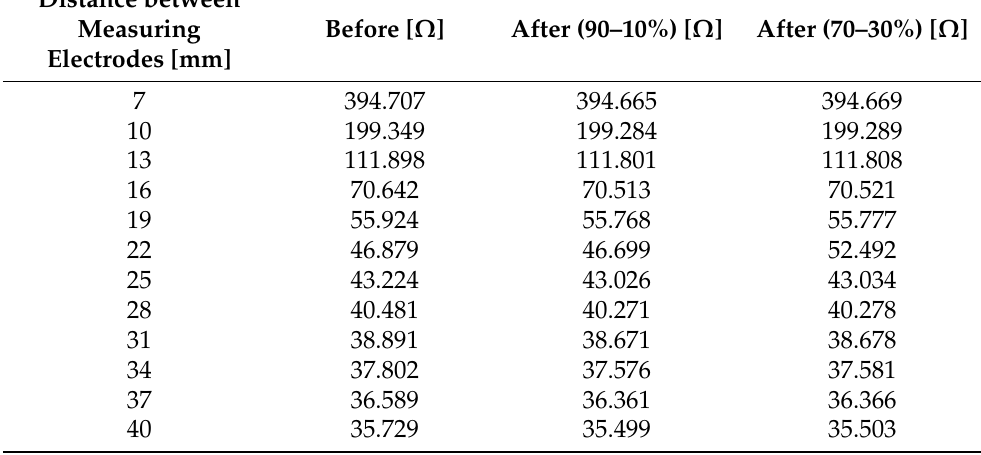
Table 5. The obtained electrical impedance values during the numerical modeling.